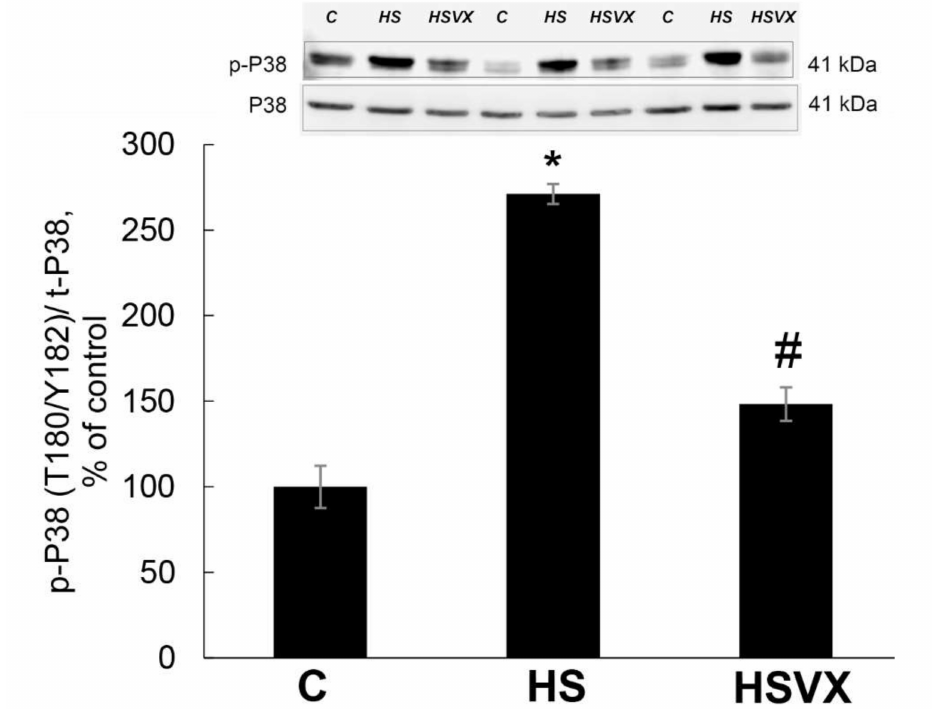
Figure 1. Evaluation of phospho-p38 content in soleus muscles of non-treated control (C), 3 days of unloading / hindlimb suspension (HS), and 3 days HS with VX-745 inhibitor (HSVX) rats by Western blotting. Values are normalized to the levels of total protein and total-p38 expression in each sample. n = 8. * indicates a significant di ff erence from the control, p < 0.05; # indicates a significant di ff erence from the HS, p < 0.05.